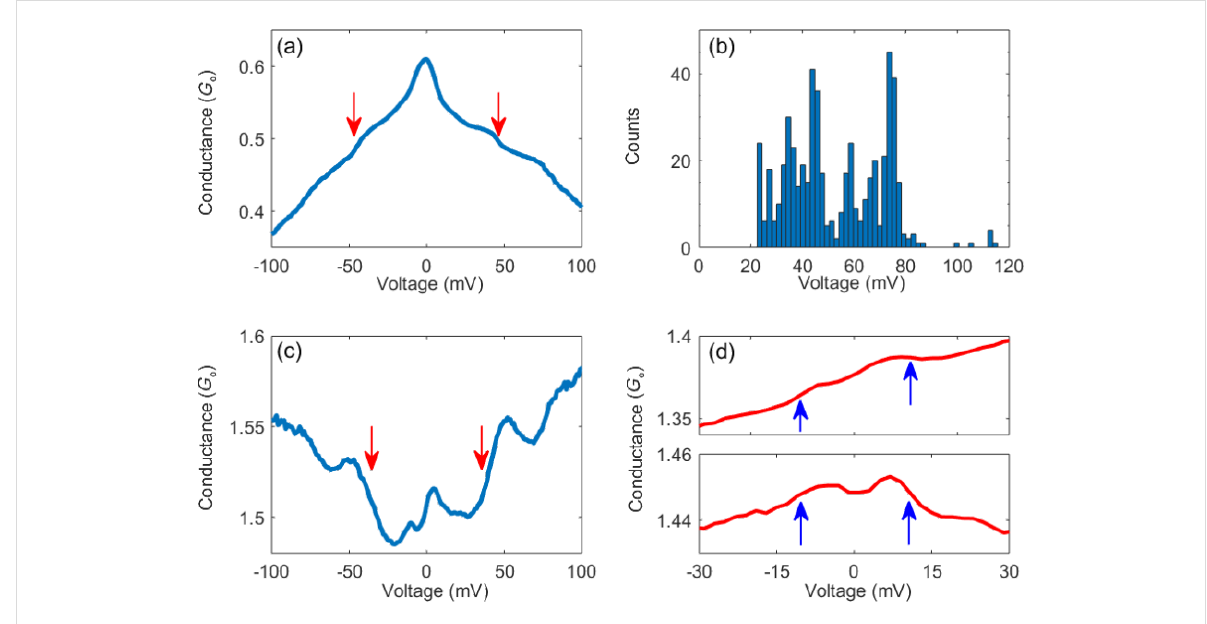
Figure 2: (a) Differential conductance vs applied voltage (d I /d V vs V ) spectra measured at ≈ 0.6 G 0 zero-voltage conductance after the introduction of vanadocene to the Ag junction. The steps in the conductance curve that are considered in the text are marked by arrows. Additional steps at higher voltage (not marked) can be seen as well. (b) Histogram of the number of times that a step feature at a certain applied voltage appears in d I /d V vs V spectra measured on different realizations of Ag–vanadocene junctions (544 spectra were analyzed in the context of step voltage). (c) Similar to (a) at ≈ 1.5 G 0 zero-voltage conductance. Note that steps down (up) in the conductance are a consequence of vibration interaction with a conduction channel that contributes more (less) than 0.5 G 0 [13]. (d) d I /d V vs V spectra taken after the introduction of molecules at ≈ 1.38 G 0 (top) and ≈ 1.45 G 0 (bottom) zero-voltage conductance. The steps in the conductance appear below 25mV and are associated with activation of metal phonon modes